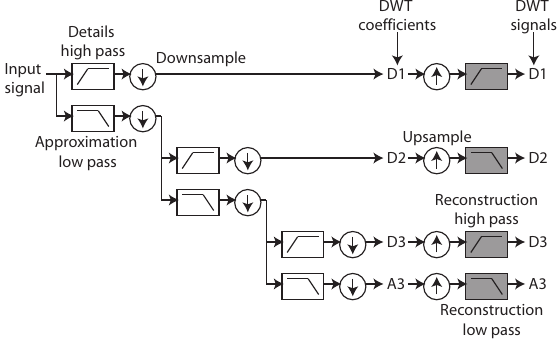
Figure 2. DWT approximation (A) and details (D) coefficients are generated via a filter bank and the repeated application of the DWT high and low pass filters. A single stage of the DWT reconstruction process can be used to generate DWT signals .